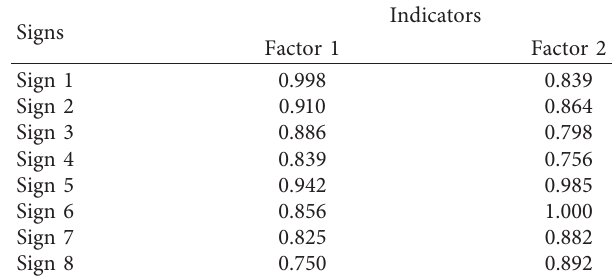
Table 8: Factor scores of each guide sign.